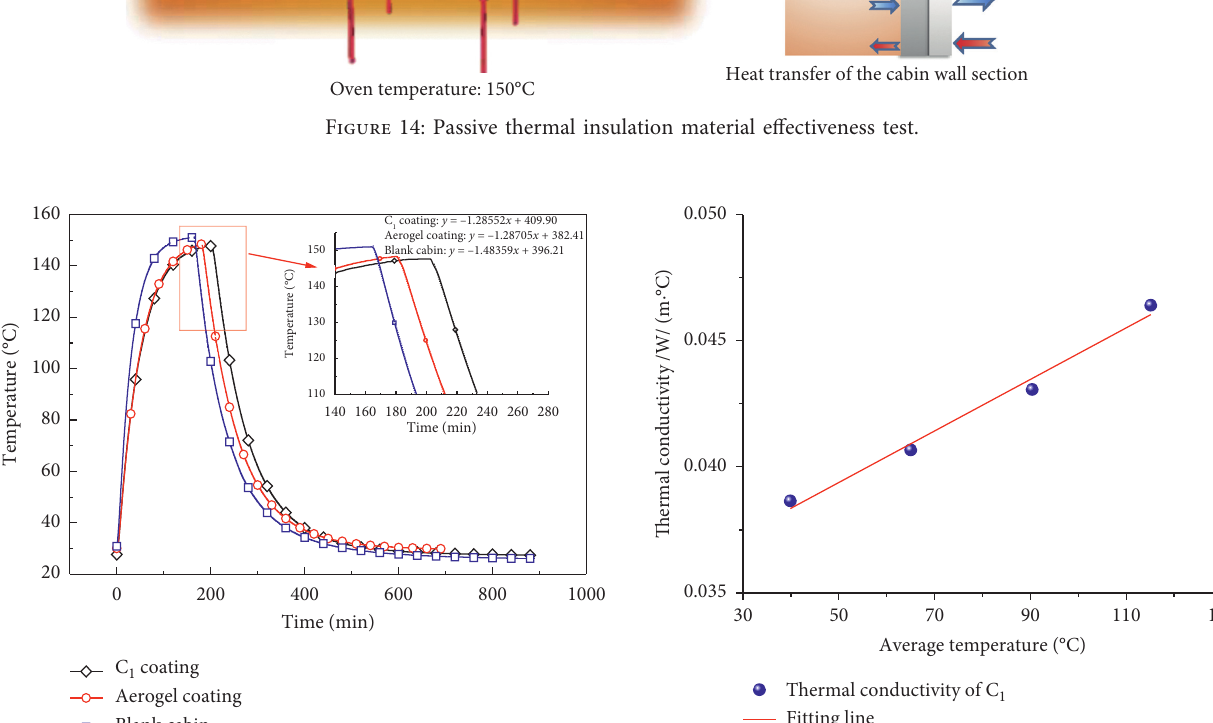
1 material at different